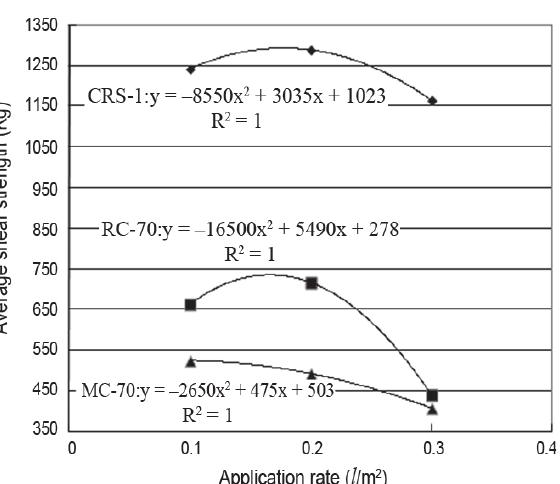
Fig. 4. a) Shear strength and displacement relationship; b) Modelling shear strength and displacement